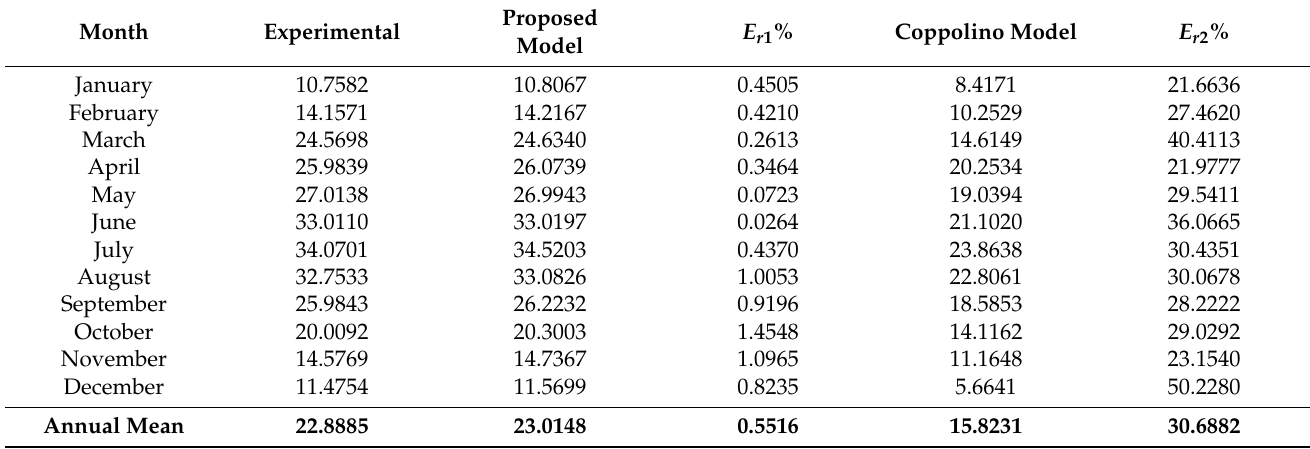
Table 7. The results for Tlemcen site (MJ/m 2 /Jour).